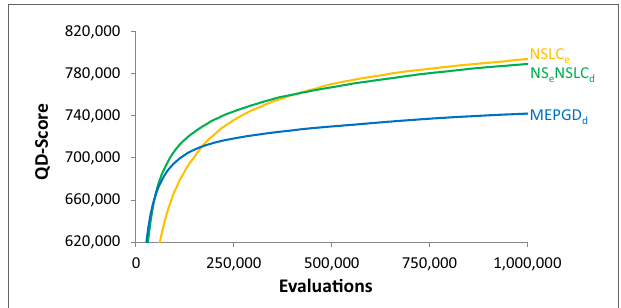
FigUre 9 | QD-score over time (symmetric gauntlet) . The progression of the QD-score on the symmetric gauntlet for the best-performing treatment from each class (according to the BC that drives search; DirectionBC: MEPGD d , EndpointBC: NSLC e , multi-BC: NS e NSLC d ) is graphed over time (averaged over 20 runs). The main result is that multi-BC treatments exhibit the best characteristics of each component BC: both increasing quickly and reaching high